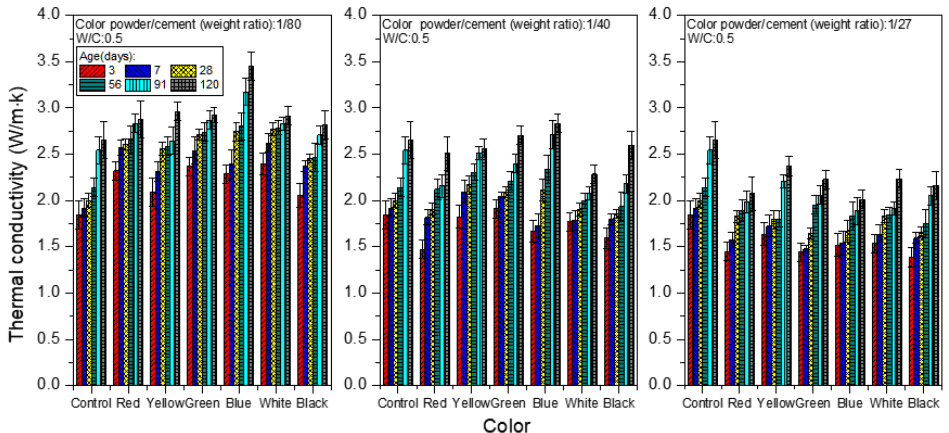
Figure 13. Thermal conductivity of colored mortar at W/C = 0.5 when weight ratios of color powder/cement at 1:80, 1:40, and 1:27 are added.